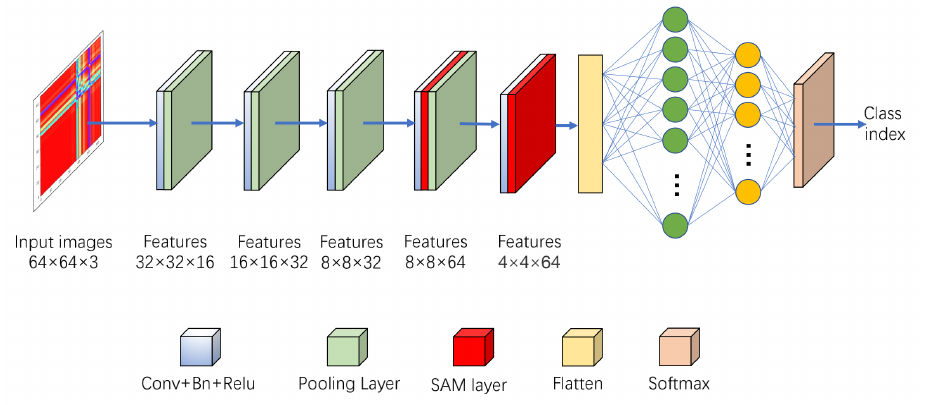
Figure 10. Flowchart of proposed convolutional neural